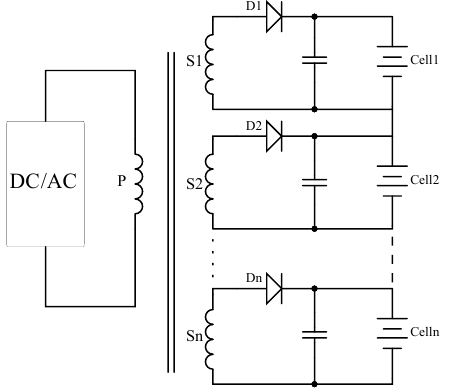
Figure 1. Conventional multi-winding balancing circuit